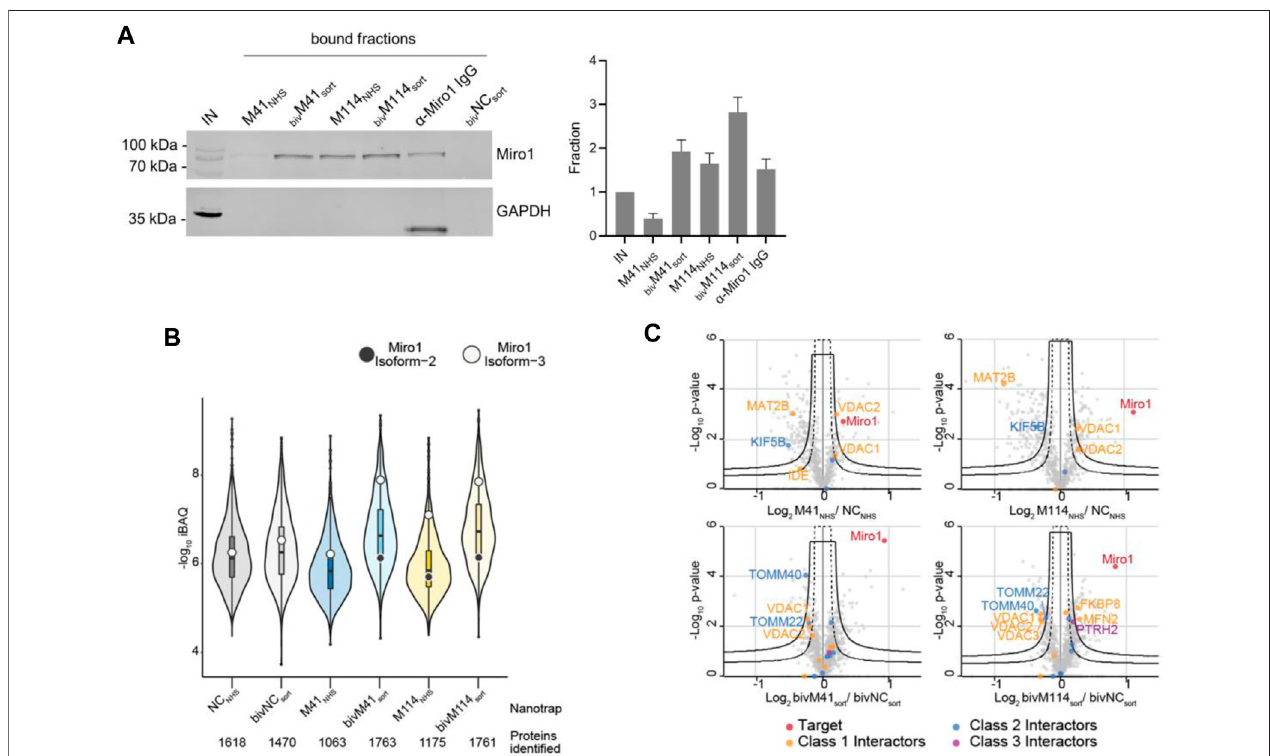
FIGURE 5 | Proteomic analysis of Miro1 capture. (A) For comparable immunoprecipitation soluble protein fraction of HEK293 cells were incubated either with monovalentNbseitherchemicallycoupledtoNHSsepharose(M41 NHS ,M114 NHS )orthebivalentformats,whichweresitespeci fi callyconjugatedtoagaroseparticlesby sortagging and click chemistry (bivM41 sort , bivM114 sort ). Input and bound fractions were analysed with an anti-Miro1 antibody. As positive control anti-Miro1 IgG immobilized on Protein A/G sepharose and as negative control a non-speci fi c bivalent and site speci fi cally conjugated nanotrap (bivNC sort ) was used. Shown is a representative immunoblot stained with an anti-Miro1 antibody. For densitometric evaluation immunoblot signals of endogenous Miro1 in the corresponding bound fractionswerenormalized totheMiro1signalintheinput,whichwassetto1.Shownarethemeansignalsfromthreeindependentbiologicalreplicates±SD. (B) Capture ef fi ciencybymono-andbivalentnanotraps.AveragediBAQ(intensitybasedabsolutequanti fi cation)valuesforMiro1isoform2(whitecircles)andisoform3(blackcircles) of three biological replicates are shown. (C) Classi fi cation of Miro1 interactor based on STRING database. Class 1: direct interactor, con fi dence score > 0.9; Class 2: direct interactor, con fi dence score < 0.9; Class 3: indirect interactor, con fi dence score >